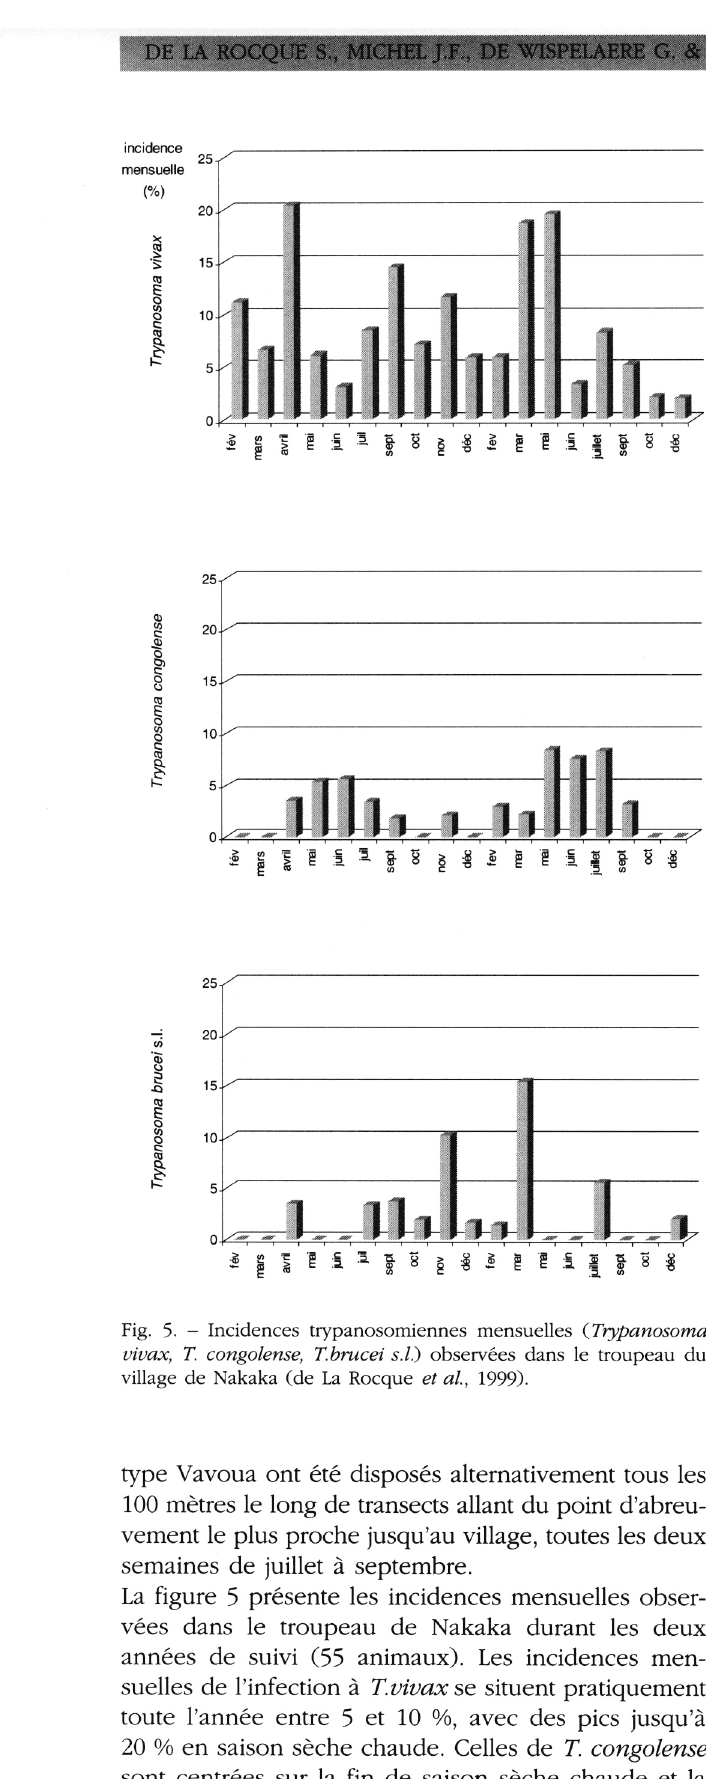
Fig. 5. - Incidences trypanosomiennes mensuelles ( Trypanosoma vivax, T. congolense, T.brucei s.l.) observées dans le troupeau du village de Nakaka (de La Rocque et al,